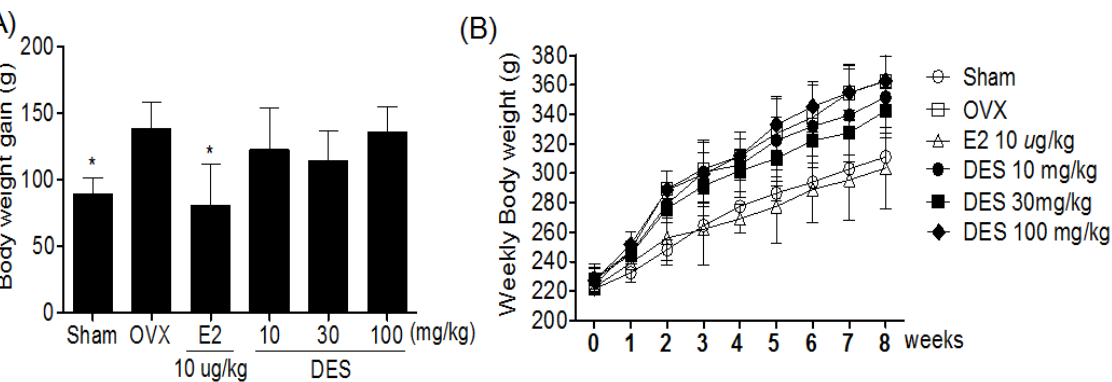
Figure 2. Effects of DES on body weight ( A ) and body weight gain ( B ) in OVX rats. The body weight was recorded weekly during the experimental period. The body weight gain was calculated by the equation: final body weight - initial body weight. Data are mean ± SD values (n = 10 per group). * p < 0.05, significantly difference from the OVX-control group.